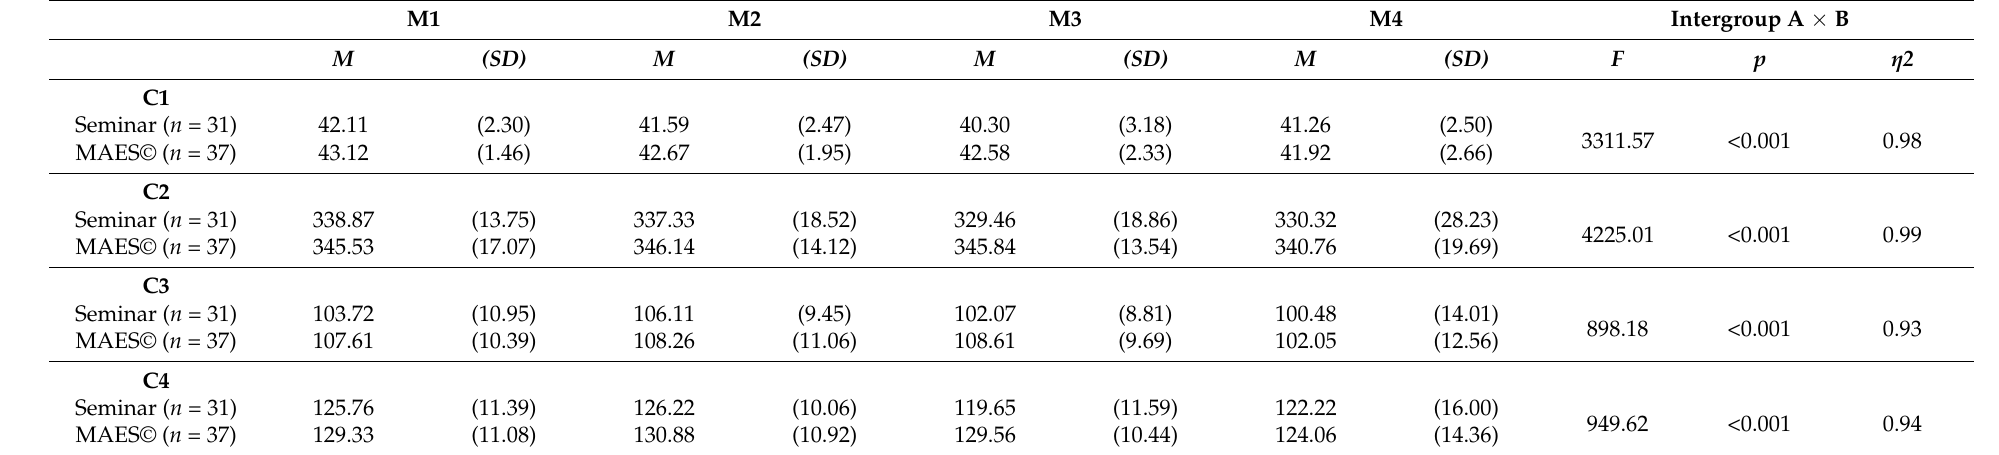
Table 7. Differences between inter-subject